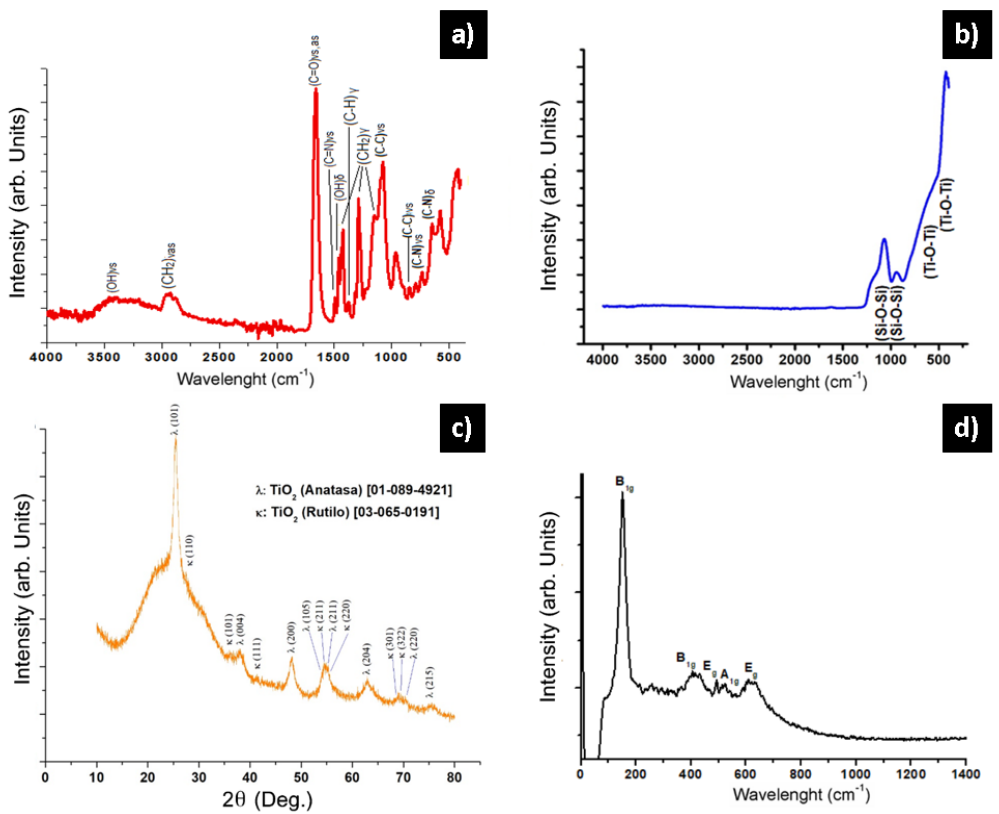
Figure 2. ( a ) IR spectra of fibers at 25 °C, ( b ) IR spectrum of fibers at 800 °C, ( c ) XRD of fibers at 800 °C and ( d ) Raman spectrum of fibers at 800 °C.